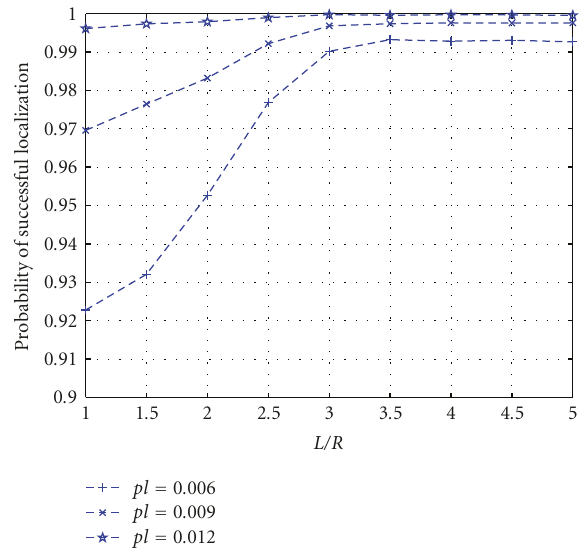
Figure 7: Probability of successful localization: Basic scheme versus Enhanced scheme. Figure 8: Probability of successful localization under di ff erent locator densities.